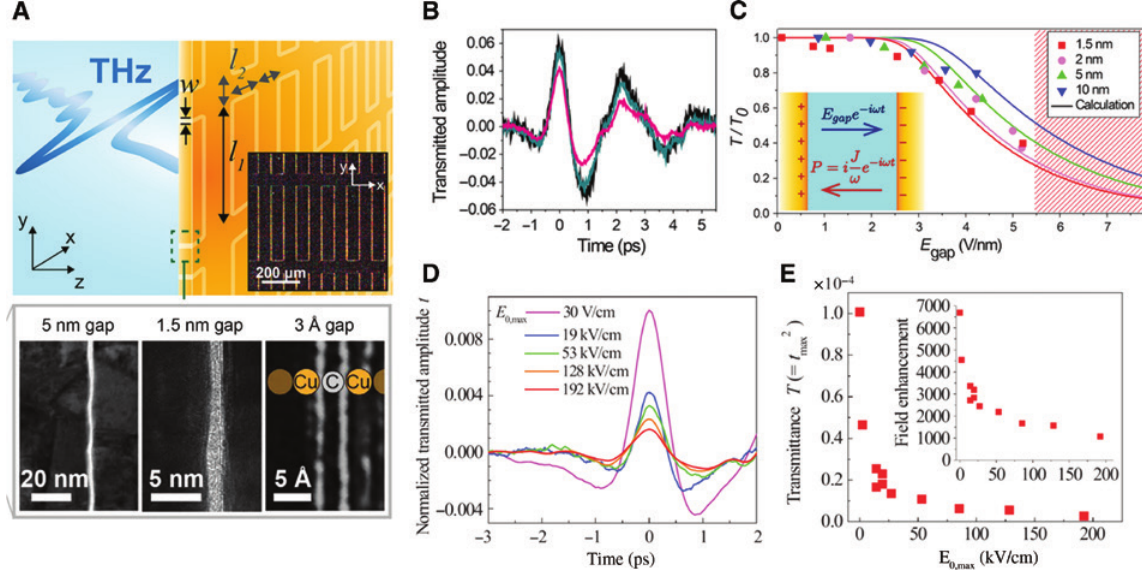
Figure 9: Terahertz funneling-induced electron tunneling in metal gaps. (A) Terahertz pulse is passing through a metallic nanogap structure. At the bottom figure, cross-sectional transmission electron microscopy (TEM) images for nanogaps are shown; 5- and 1.5-nm gaps composed of alumina layer sandwiched by gold and 3-angstrom gap composed of a single-layer graphene sandwiched by coppers. (B) Measured amplitudes of transmitted terahertz pulses through the 1.5-nm alumina gap as a function of incident terahertz field strengths (black: 20 kV/cm, green: 75 kV/cm and red: 150 kV/cm). (C) Measured (dots) and calculated (lines) terahertz transmittance normalized by minimum transmittance value as a function of field strength inside the gap for different alumina layer thicknesses. Dashed region indicates that nanogaps are damaged after the measurement when the corresponding field strength is applied at the gap. (D) Measured amplitudes of transmitted terahertz pulses through the copper–graphene–copper gap as a function of incident terahertz field strengths. (E) Absolute terahertz transmittance as a function of field amplitude inside the graphene gap. Inset shows terahertz field enhancement factors as a function of incident field strength. The figures (A–C) and (D, E) are reproduced from References [13] and [14],